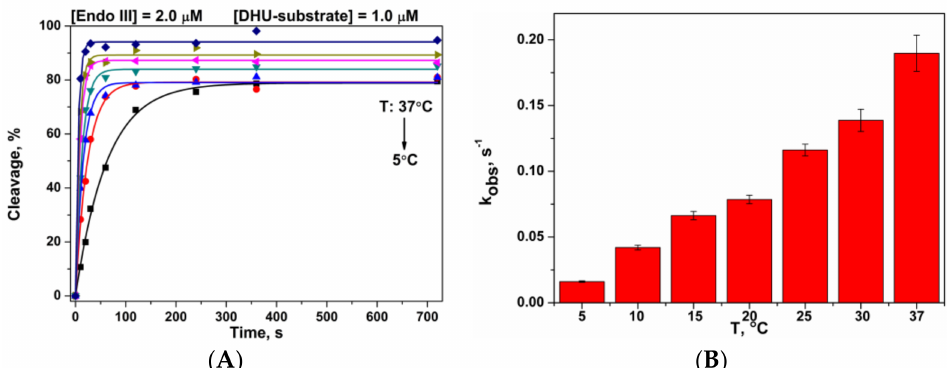
Figure 5. ( A ) Kinetics of accumulation of the DNA product formed in the N -glycosylase and apurinic/apyrimidinic (AP)-lyase reactions, as detected by the polyacrylamide gel electrophoresis (PAGE) experiments. To visualize kinetic curves in the initial time region different colors are used. ( B ) The observed rate constants for DHU-substrates’ cleavage by Endo III at different temperatures, [Endo III] = 2 µ M, [DHU-substrate] = 1 µ